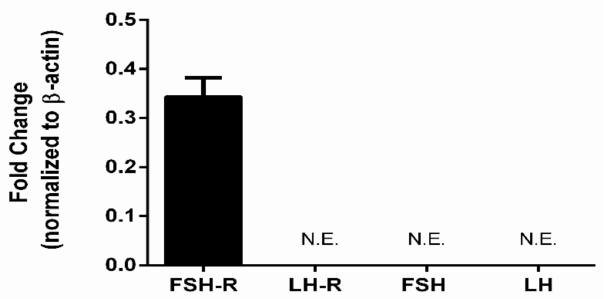
Figure 8. Expression of FSHR, LHR, FSH, and LH in human corneal epithelial cells. FSHR was the only one expressed by the epithelial cells. (See Supplementary Materials—Figure